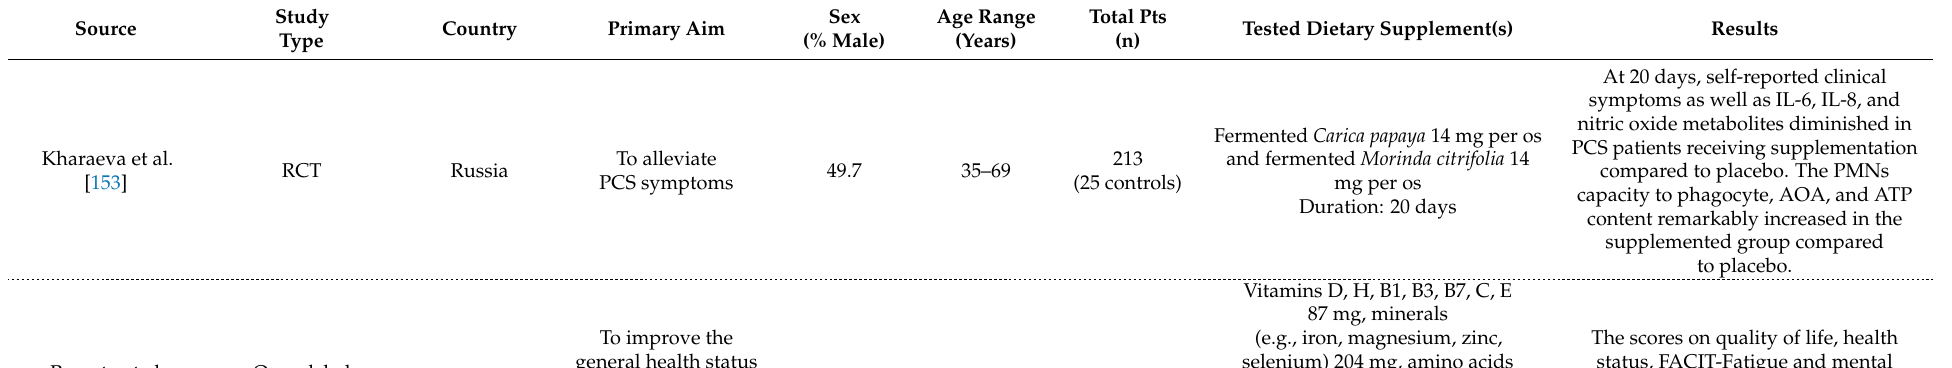
Table 5. Studies on complementary and alternative medicine in long